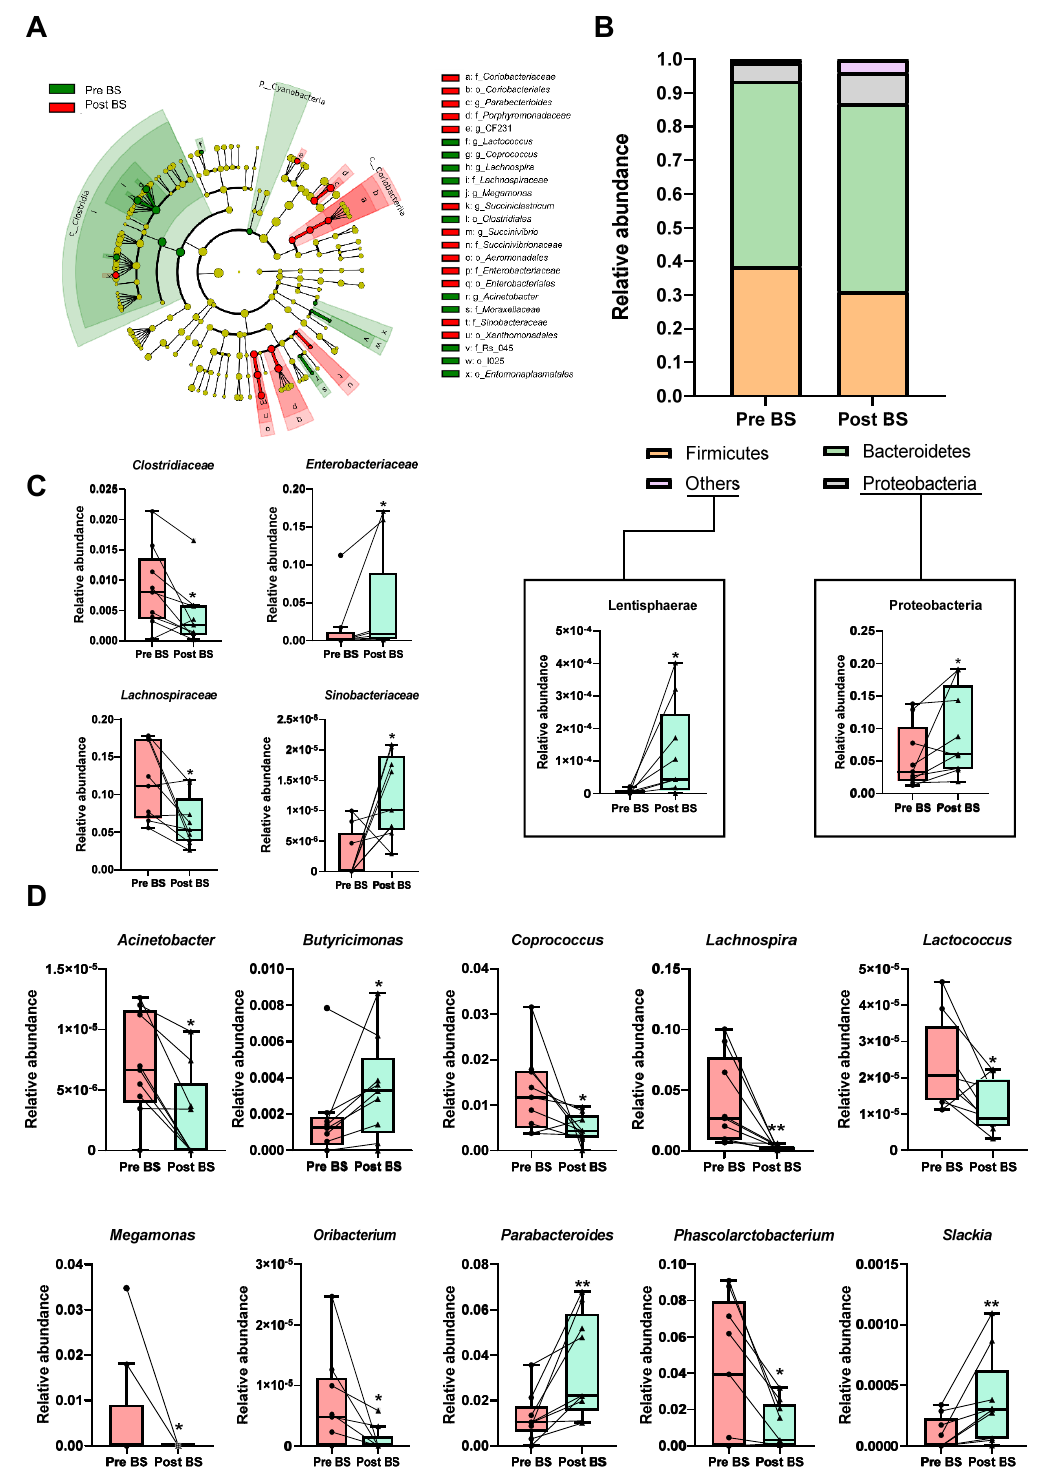
Figure 2. Effect of bariatric surgery on gut microbiota composition of patients with severe obesity. ( A ) Cladogram showing the main differences in gut microbiota composition before (Pre BS) and after (Post BS) bariatric surgery based on linear discriminant analysis effect size (LEfSe). Colour denotes taxa enriched in Pre BS samples (red) and Post BS samples (green). A cut-off value of LDA > 2 and a Wilcoxon p value < 0.05 were set up to identify discriminating taxa. The LEfSe results plot is provided in Figure S1. ( B ) Relative abundance of phyla in the patients with severe obesity Pre BS and Post BS. ( C ) Differences in the relative abundance at class level of the patients with severe obesity Pre BS and Post BS. ( D ) Differences in the relative abundance at genus level of the patients with severe obesity Pre BS and Post BS. Nonparametric Wilcoxon signed-rank test. * p < 0.05; ** p < 0.01 vs. Pre